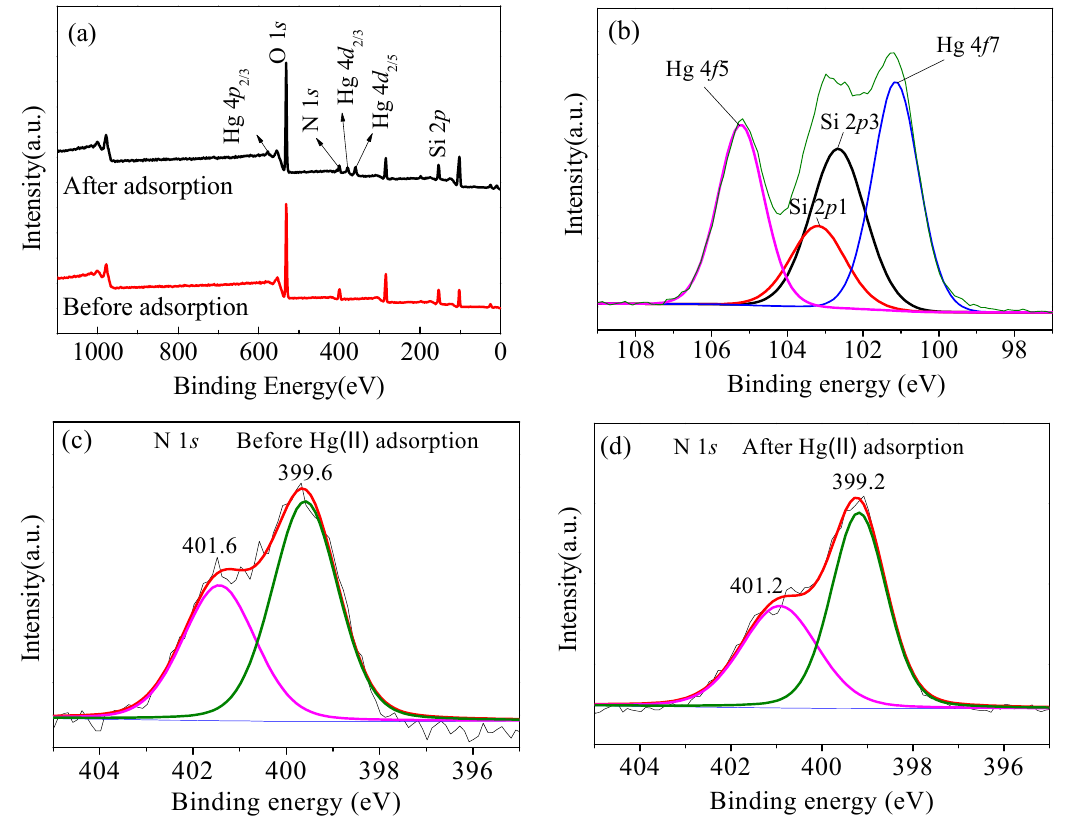
Figure 16. ( a ) XPS spectra of wide scan; ( b ) Hg 4 f after adsorption; ( c ) N 1 s spectra of CoFe 2 O 4 @SiO 2 – NH 2 nanoparticles before; ( d ) and after adsorption.